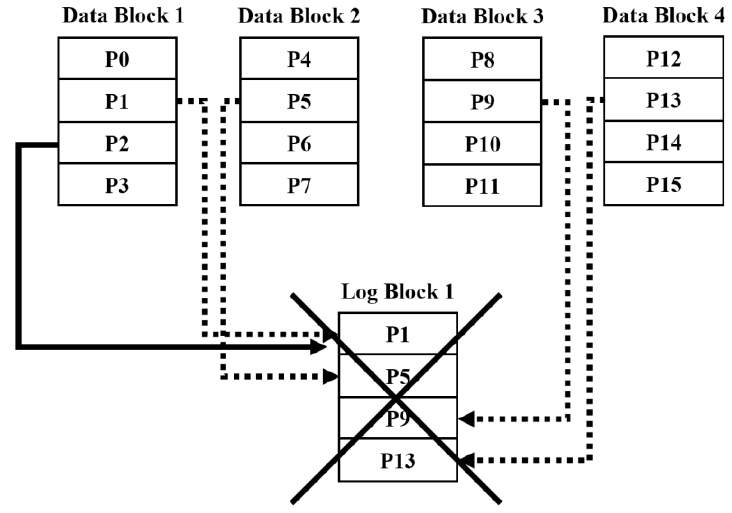
Figure 2. Problem of 1:1 availability.